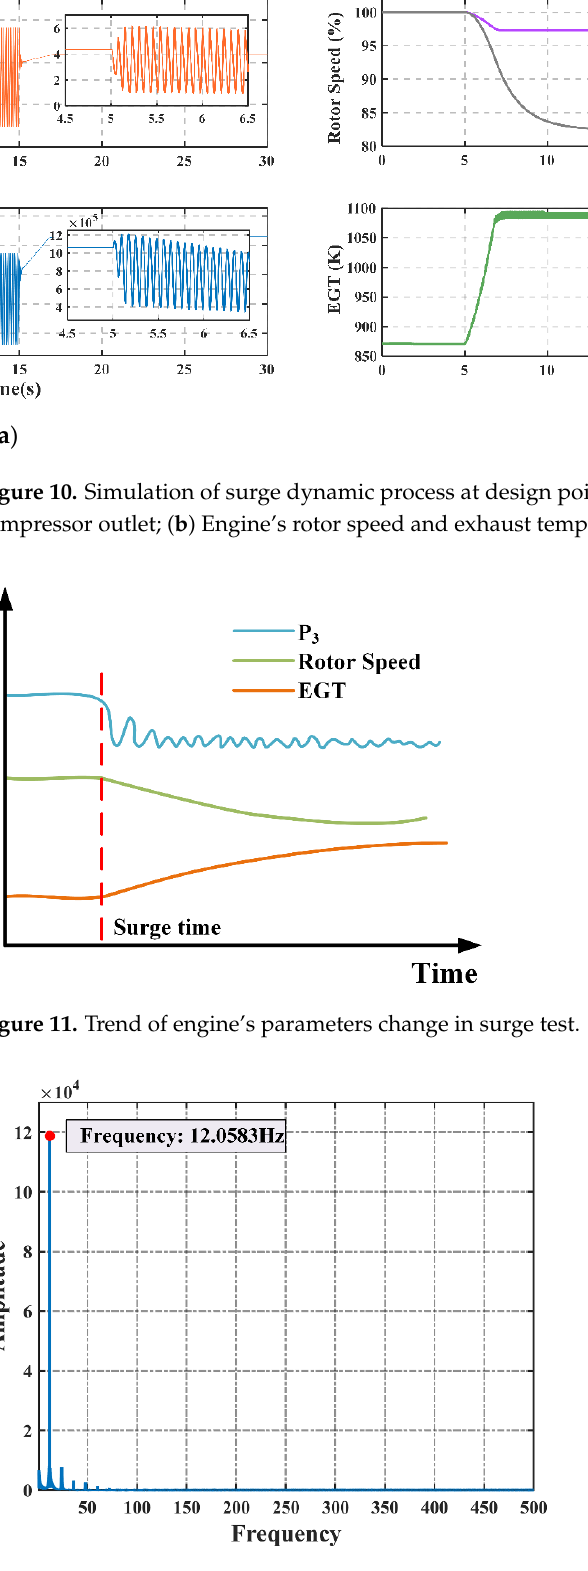
Figure 12. Fast Fourier transform results of P3.